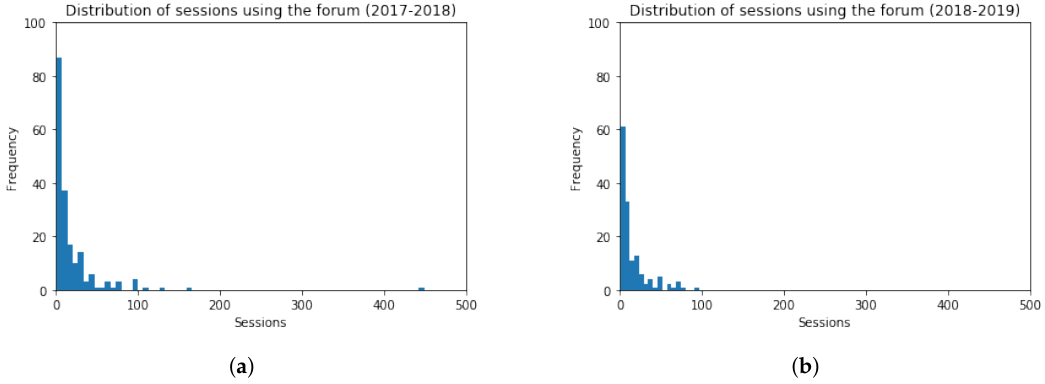
Figure 15. Histogram Graphs for the Number of Sessions using the Forum. ( a ) 2017–2018 ( b ) 2018–2019.